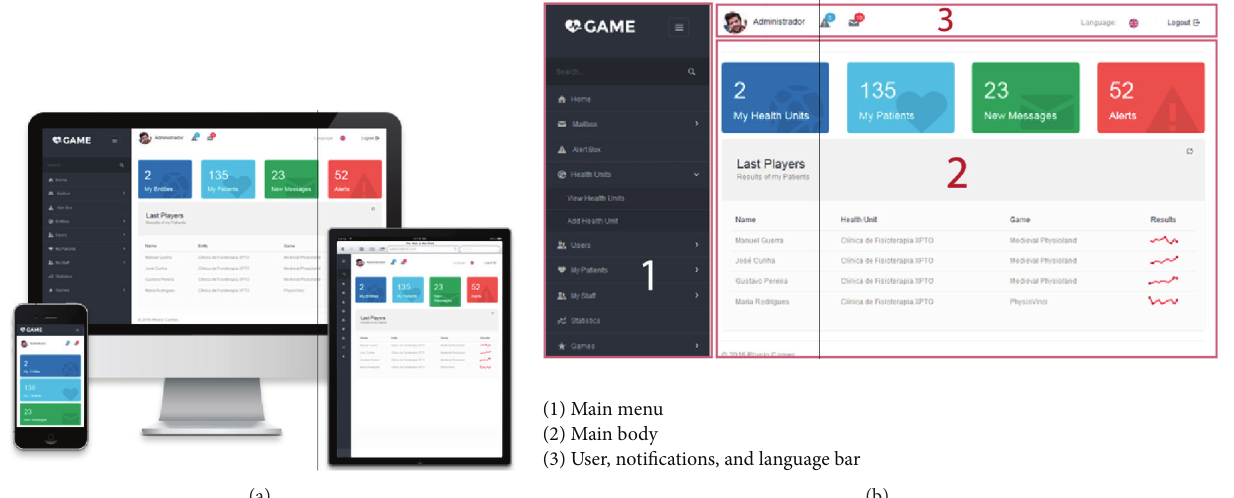
Figure 3: (a) Web application with responsive layout. (b) Main application areas.